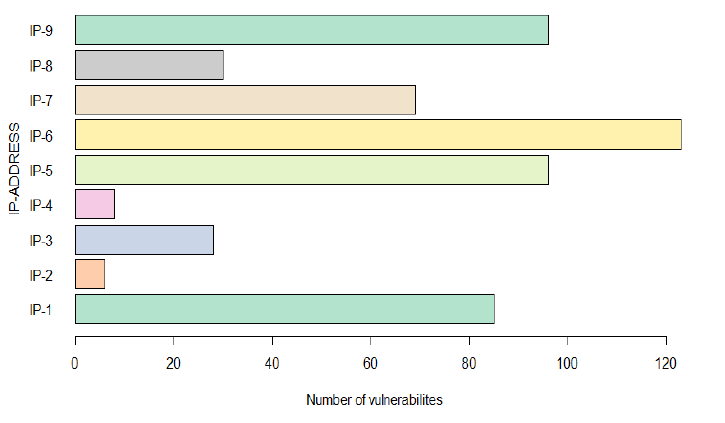
Figure 7. Number of Vulnerabilities per IP. A total of 541 vulnerabilities were identified across nine IPs of the same